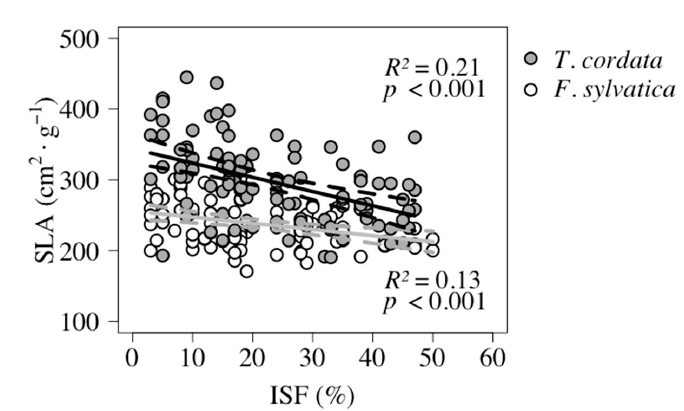
Figure 4. Specific leaf area (SLA) in association with light, measured as indirect site factor (ISF). Sample size for F. sylvatica was n = 96 and for T. cordata n = 99. The trends were significant for both tree species ( p < 0.001) and are shown as solid lines (black shows the trend for T. cordata and grey shows the trend for F. sylvatica ). Dashed lines show the 95% confidence intervals.